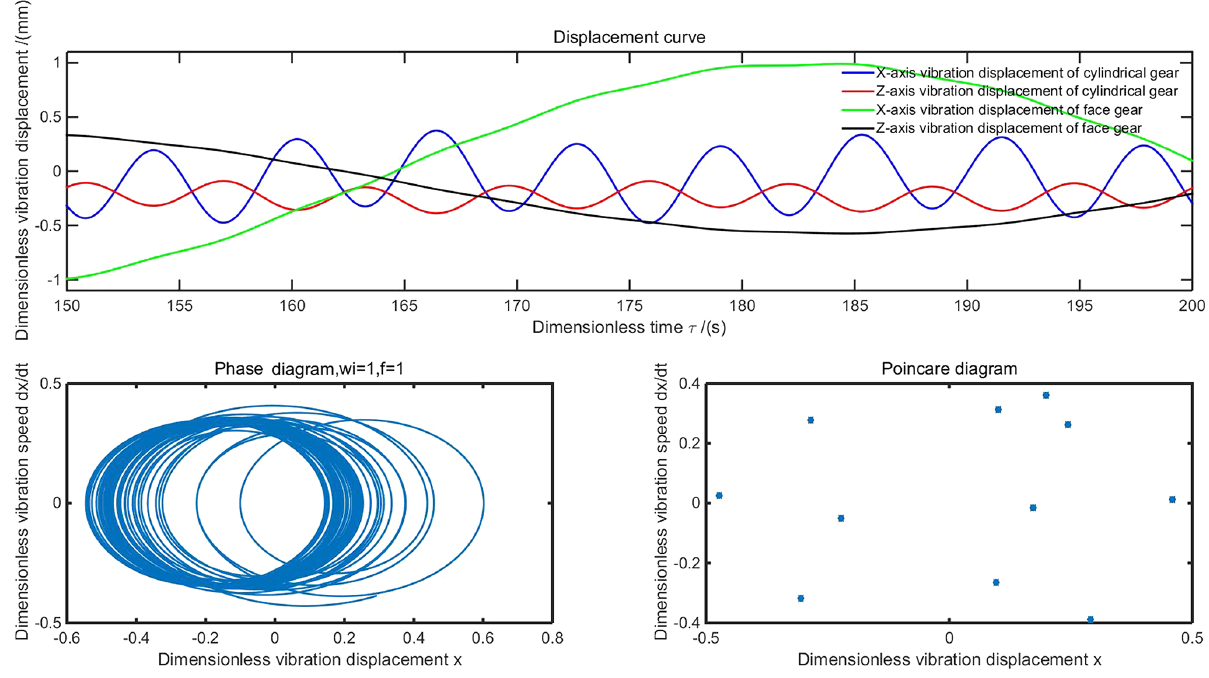
Figure 14. Displacement, phase, and Poincare diagrams of nonlinear